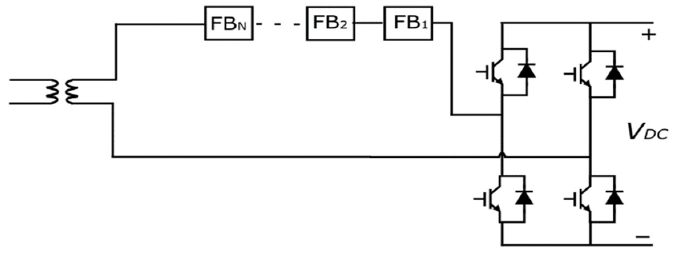
Figure 25. Single phase diagram of HBHMC.